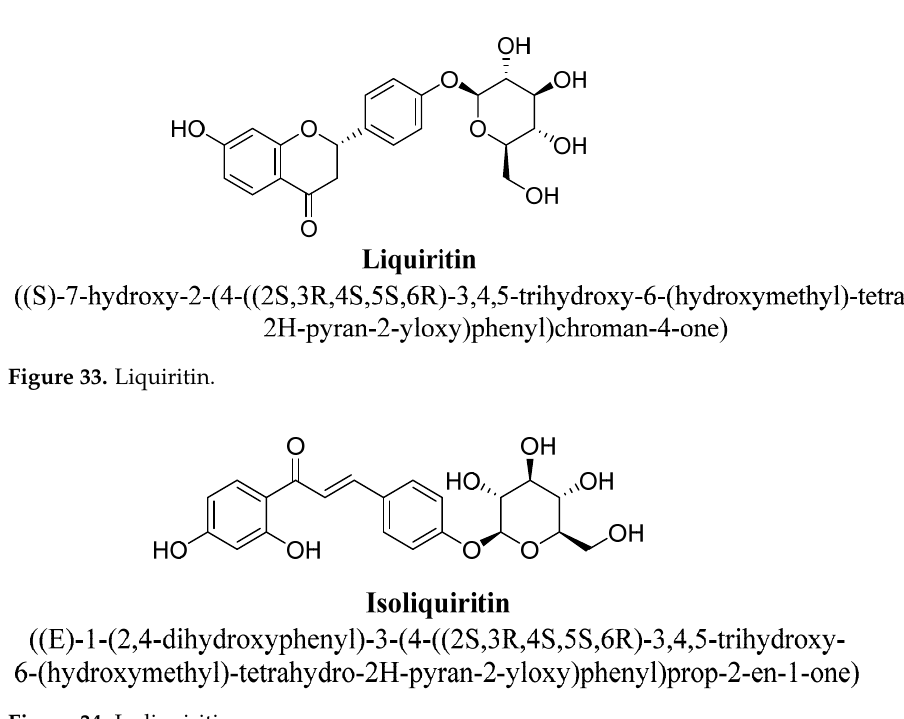
Figure 34. Isoliquiritin.